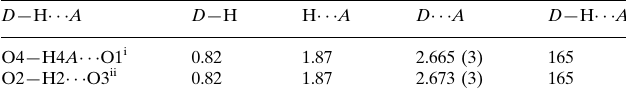
Hydrogen-bond geometry (A˚ , (cid:4)